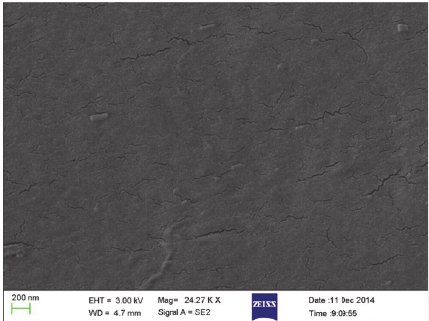
Figure 6: SEM spectrum of esterification PU membrane.